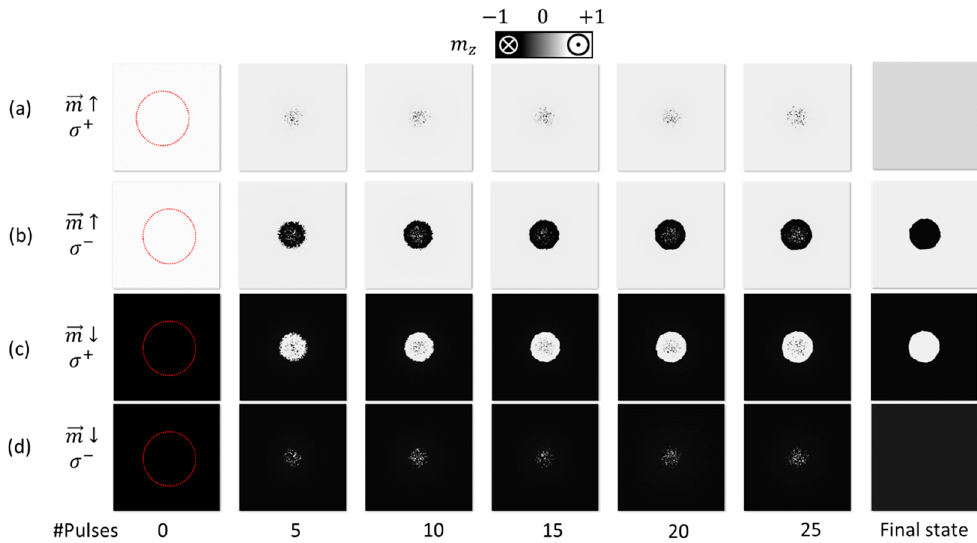
Figure 2. Snapshots of the magnetization after different laser pulses for different combination of the initial state ( 𝑚⃗ ↑ , 𝑚⃗ ↓ ) corresponding to ( a,b ) and ( c–d ) respectively and laser helicities ( 𝜎 (cid:2878) , 𝜎 (cid:2879) ) corresponding to ( a–c ) and ( b–d ) respectively under the influence of the IFE ( F = 0.55 J/m 2 , 𝐵 (cid:3014)(cid:3016)(cid:2868) = 5 T ). Each pulse is applied every ∆ t = 1 ns. The last snapshot shows the final relaxed state after 25 laser pulses. A video of these HD-AOS is provided as Supplementary Material (video S1).